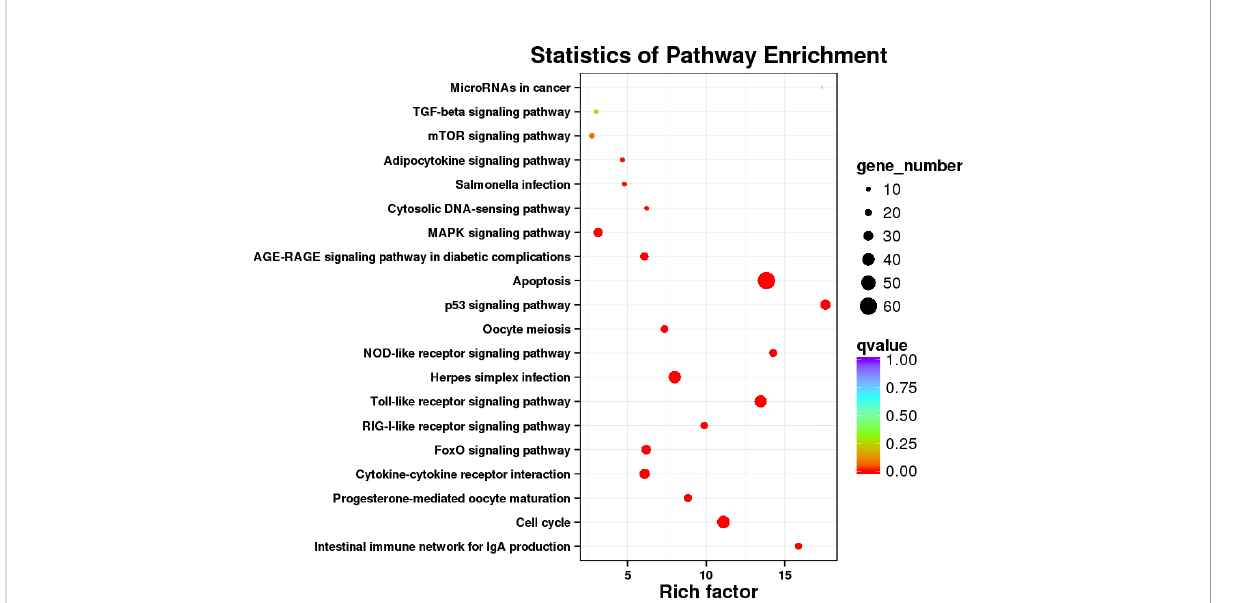
FIGURE 5 Scatterplot of the KEGG pathways involved in the immune system and cell growth and death. Rich factor represents the ratio of the number of DEGs and the number of all genes in the